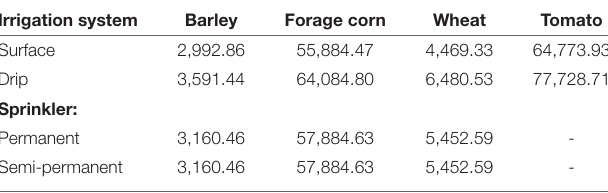
TABLE 1 | Average yields (kg/ha) by irrigation systems from 2009 to 2015. Irrigation system